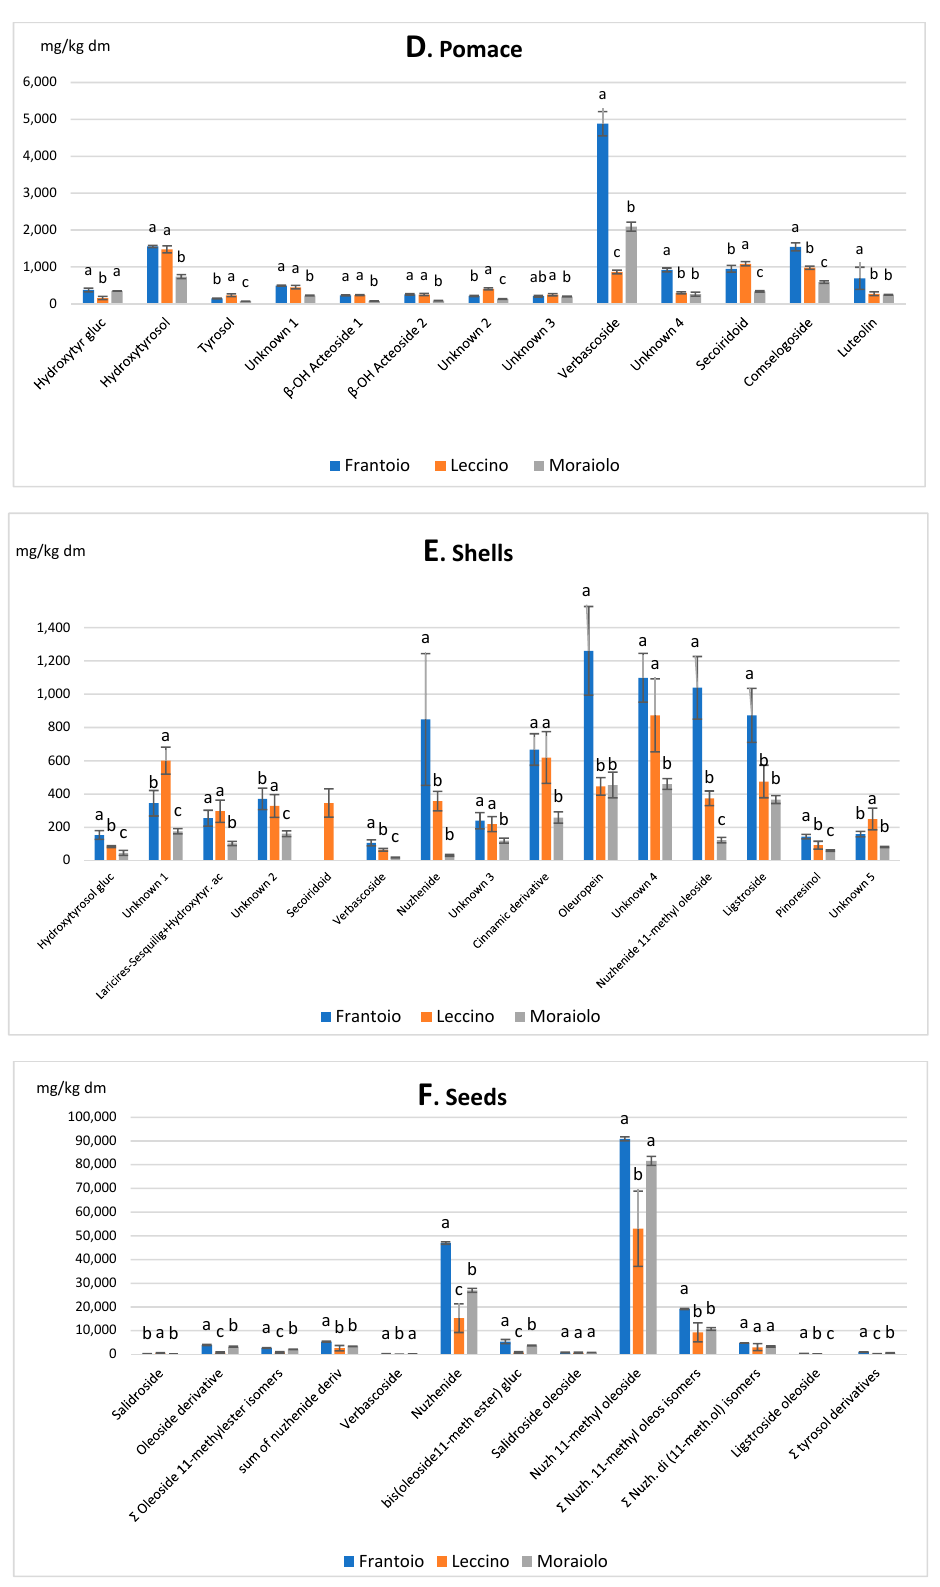
Figure 2. Distribution of phenolic compounds in the different extracts of the three varieties: ( A ) Leaves, ( B ) Branches, ( C ) Fruits; ( D ) Pomace, ( E ) Shell, ( F ) Seeds. For each molecule, different letters indicate different contents among the cultivar (the amount of each compounds ± SD is also reported in Table S3).